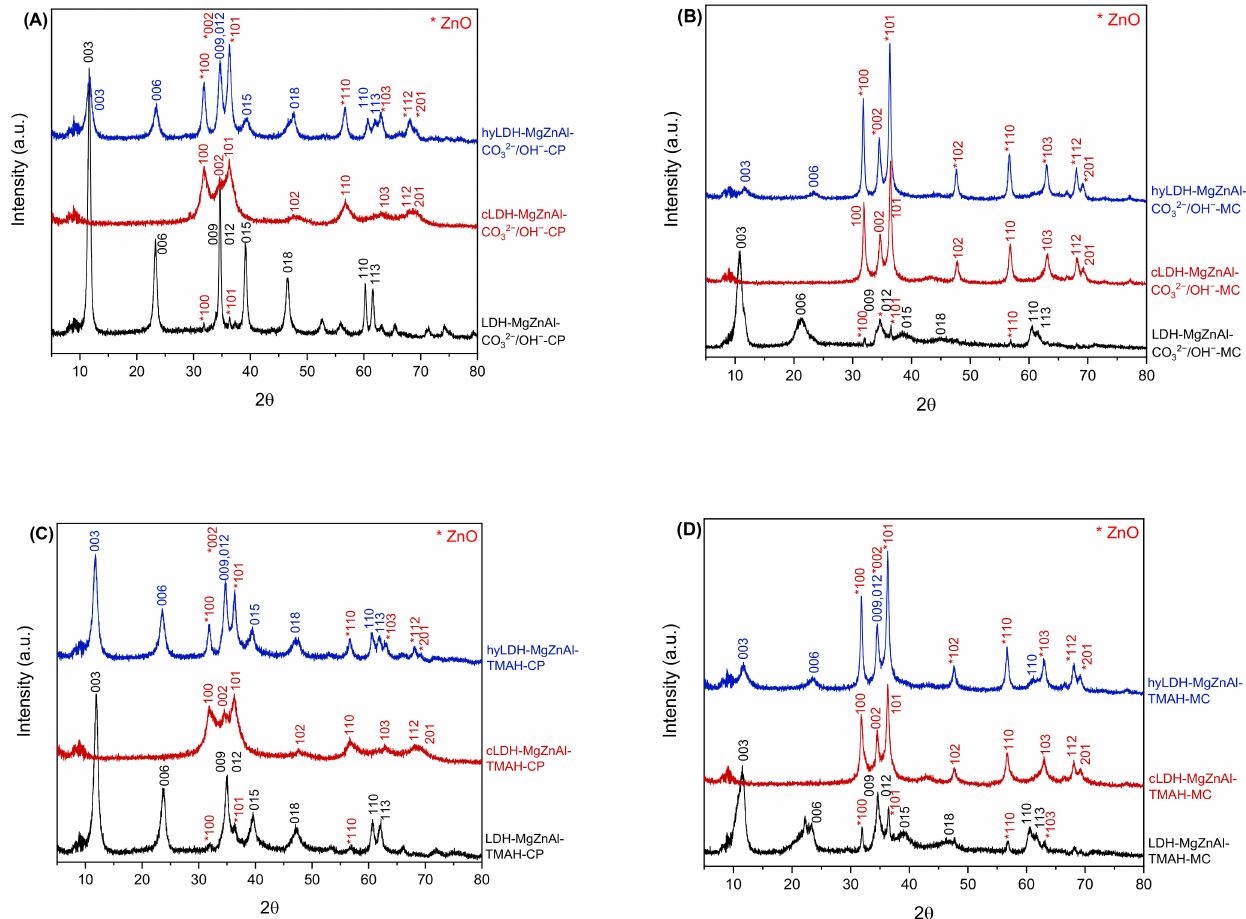
Figure 1. XRD patterns of the materials synthesized though ( A ) co-precipitation and ( B ) mechano- chemical method, both in the presence of Na 2 CO 3 /NaOH, and ( C ) co-precipitation and ( D ) mechano- chemical method, both in the presence of TMAH;